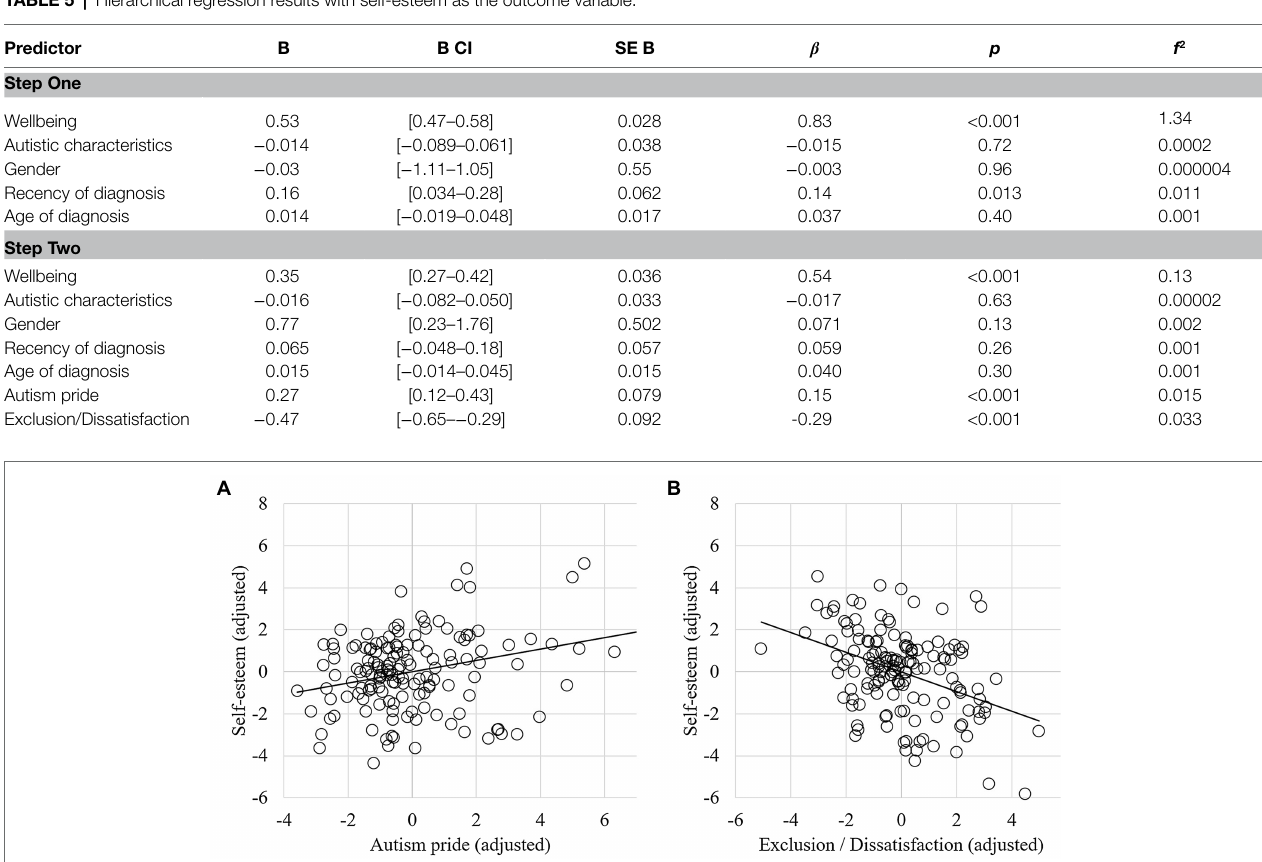
FIGURE 2 | Partial regression plots showing the relationship between self-esteem and (A) “autism pride” and (B) “exclusion/dissatisfaction” (controlling for other variables in the model).